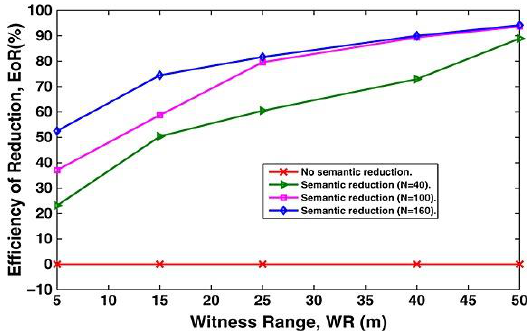
Fig.14. Impact of witness range on efficiency of reduction